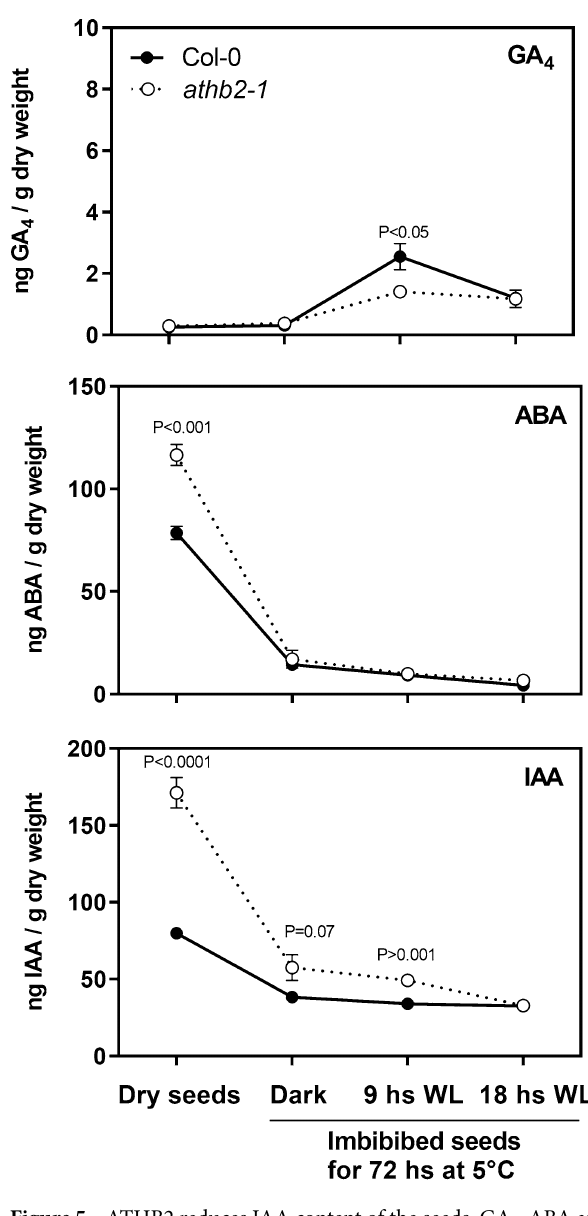
( A ) mature dry seeds. ( B ) 72 h stratified imbibed seeds in darkness (prior to light irradiation). ( C ) 72 h stratified imbibed seeds in darkness and then irradiated for 9 h under WLc. ( D ) 72 h stratified imbibed seeds in darkness and then irradiated for 18 h under WLc. Significant differences between means are shown with different letters ( p < 0.05 by ANOVA followed by Fisher post